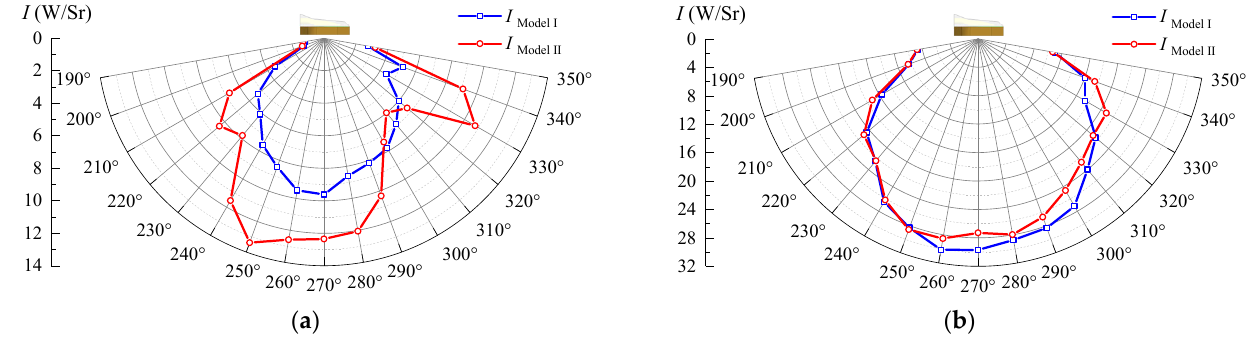
Figure 28. Total infrared radiation intensity of model. ( a ) 3–5 µ m band; and ( b ) 8–14 µ m